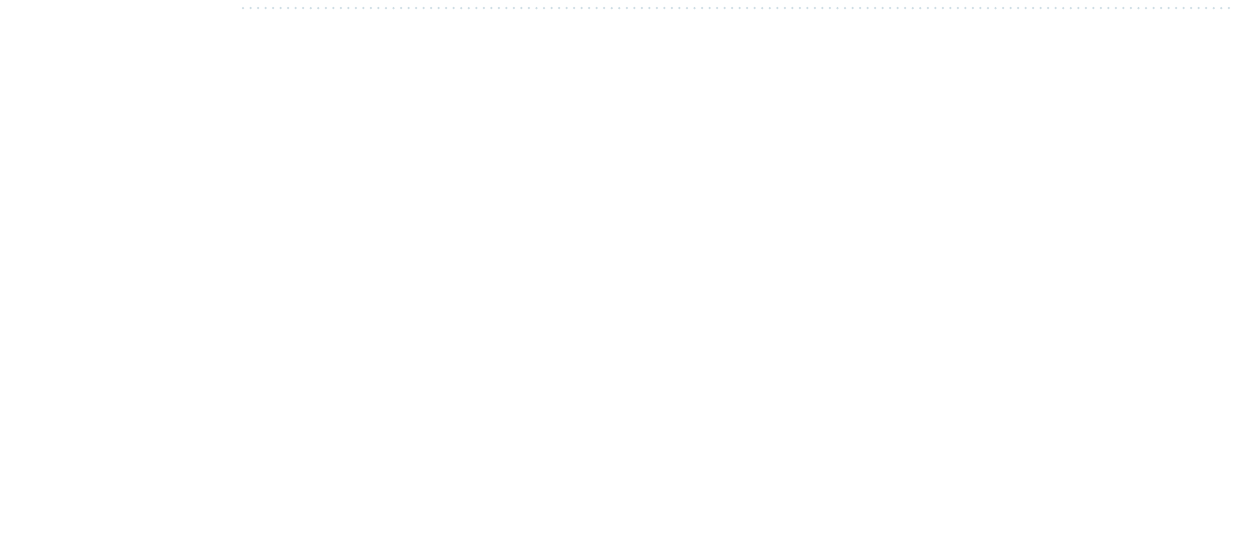
Figure 3. Example of molecular search by 13 C NMR